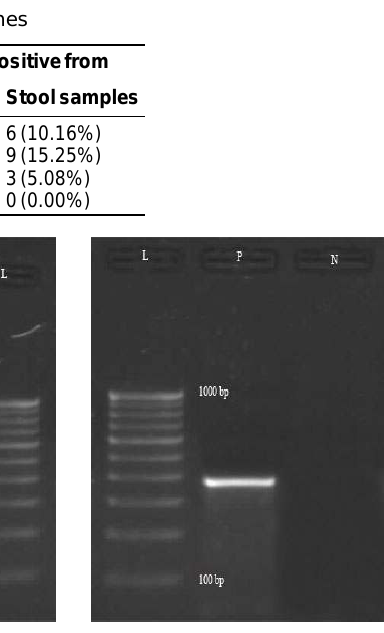
Figure-1. Agarose gel showing PCR amplified product (614 bp) for stx1 gene in E. coli isolates. P: Positive control, N: Negative control, L: DNA Ladder, stx1: Positive samples